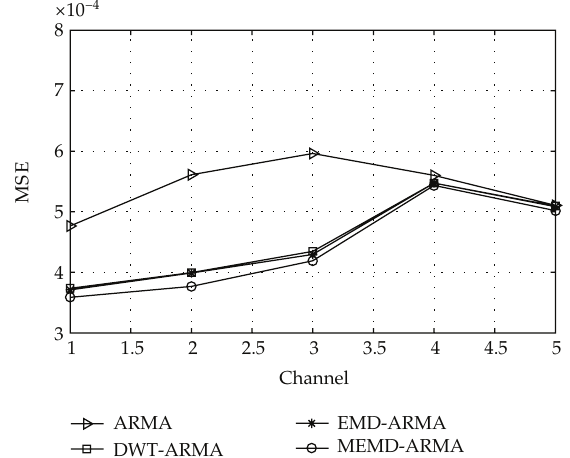
Figure 15: Comparison (cid:2) in MSE (cid:3) of proposed MEMD-ARMA model with ARMA, DWT-ARMA, and EMD- ARMA for di ff erent channels of financial